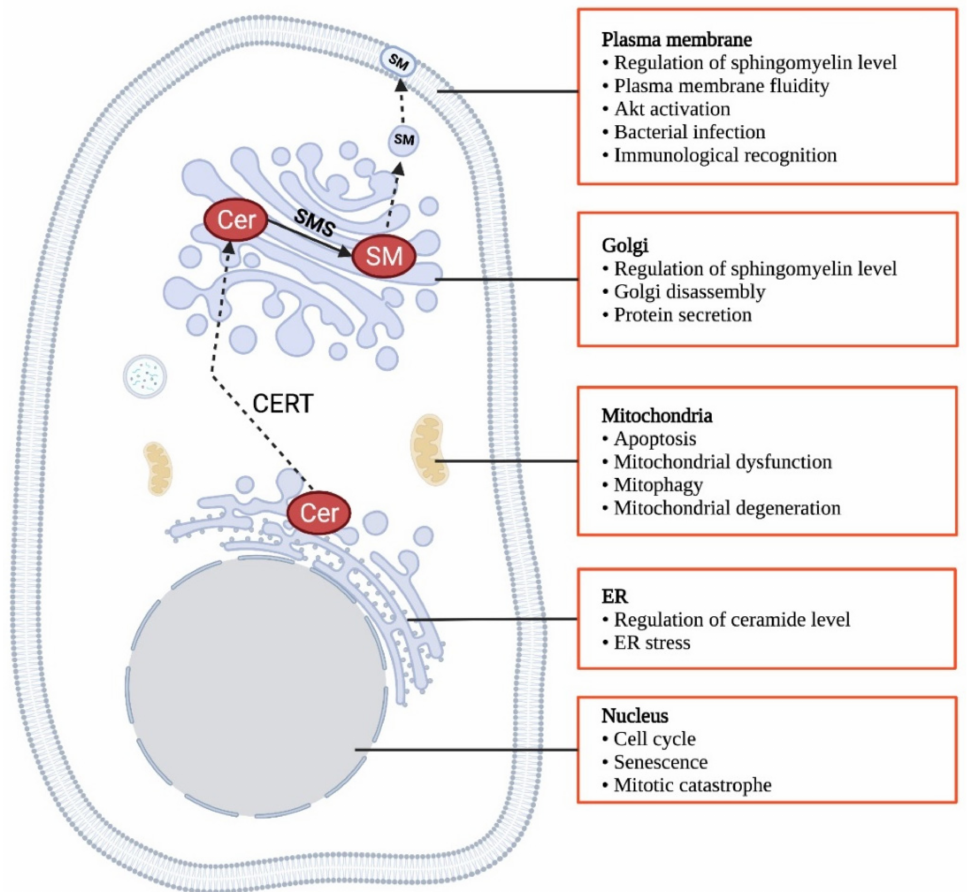
Figure 4. Biological functions of CERT. Created in Biorender.com (accessed on 11 November